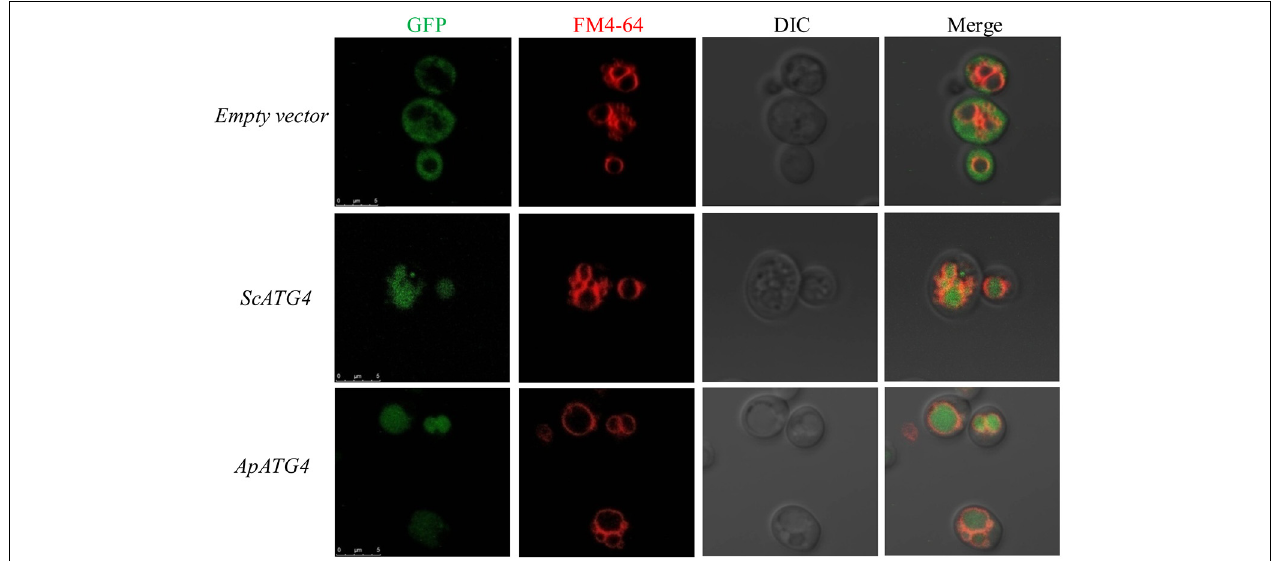
FIGURE 3 | Functional complementation of ApAtg4 in atg4 mutant yeast. ApATG4 cDNA was cloned and expressed in a yeast atg4 mutant in a GFP-Atg8 background. The yeast ATG4 ( ScATG4 ) and the empty vector were used as positive and negative controls, respectively.